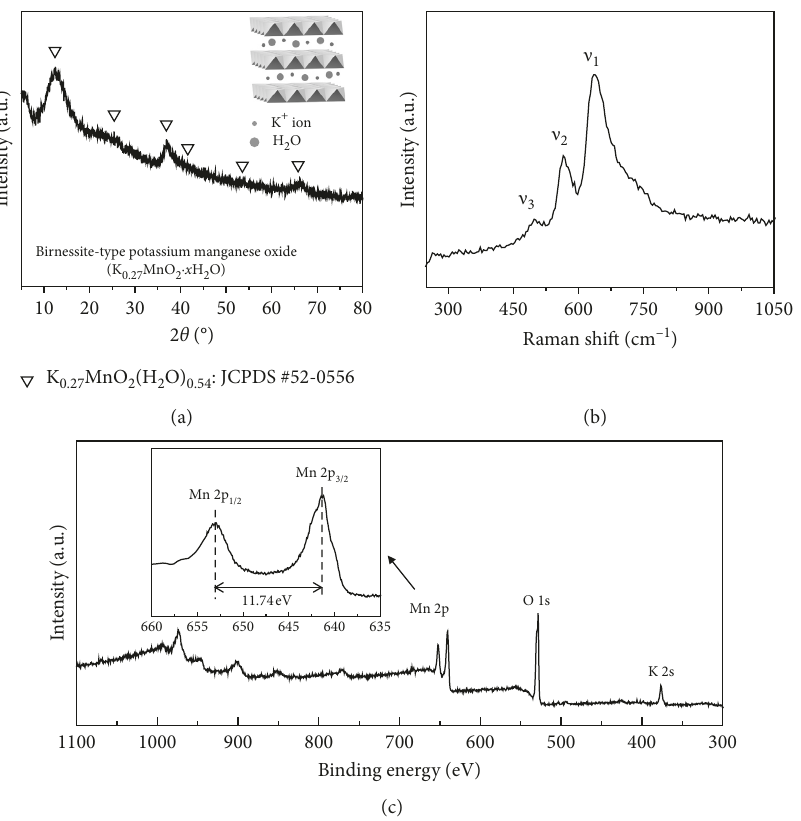
Figure 2: (a) Powder-XRD and (b) Raman spectrum for MnO of Mn 2p